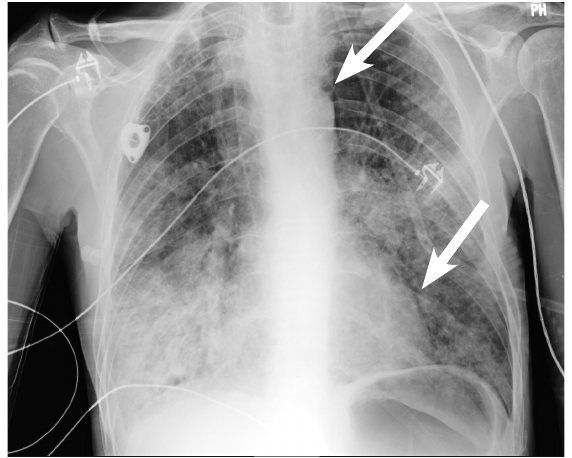
Figure 3. Coronal computed tomography exhibiting a deficit in the right tracheal wall with a cavitary space previously occupied by the large soft tissue mass seen in